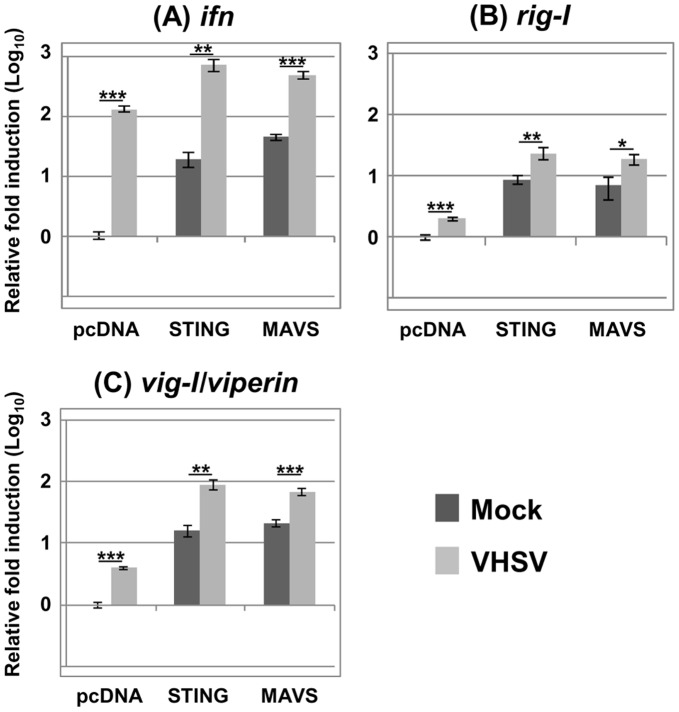
Overexpression of STING induced IFN and ISG expression.EPC cells were transfected with 2 µg of pcDNA vector encoding STING, or MAVS as a positive control, or an empty vector (pcDNA) as a negative control. At 48 h posttransfection, EPC were infected or not with VHSV at an MOI of 1 and incubated at 15°C for 24 h before total RNA extraction. Quantitative Real-time RT-PCR was conducted using primers targeting IFN (A), RIG-I (B) and Viperin (C). The β-actin gene was used as an internal control to normalize the cDNA template and to do real-time PCR calculations. SD of triplicate experiments has been calculated. Asterisks indicate significant difference (*p<0.05, **p<0.01 and ***p<0.001) as determined by Student’s t test.